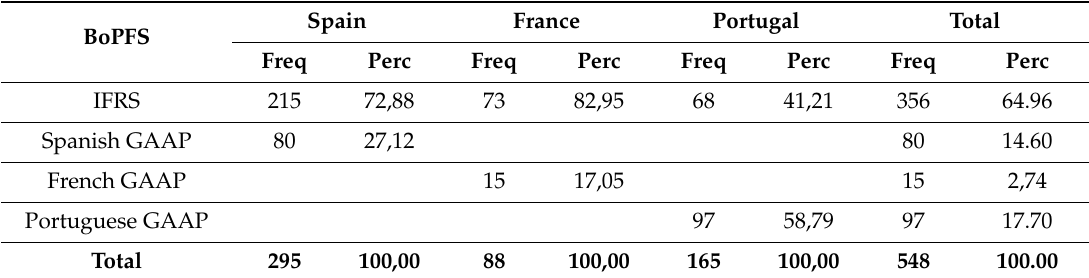
Table 3. Frequencies on the basis of presentation of financial reporting (BoPFS) per